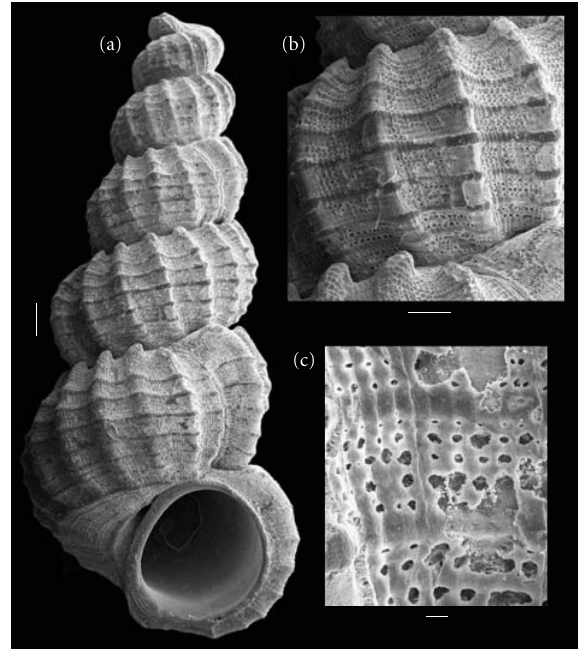
Figure 8: (a–c) Opalia eolis (MNRJ 17.170); (a) ventral view and (b), (c) detail of teleoconch ornamentation. Scale bars: (a) 500 μ m and (b), (c) 100 μ m.